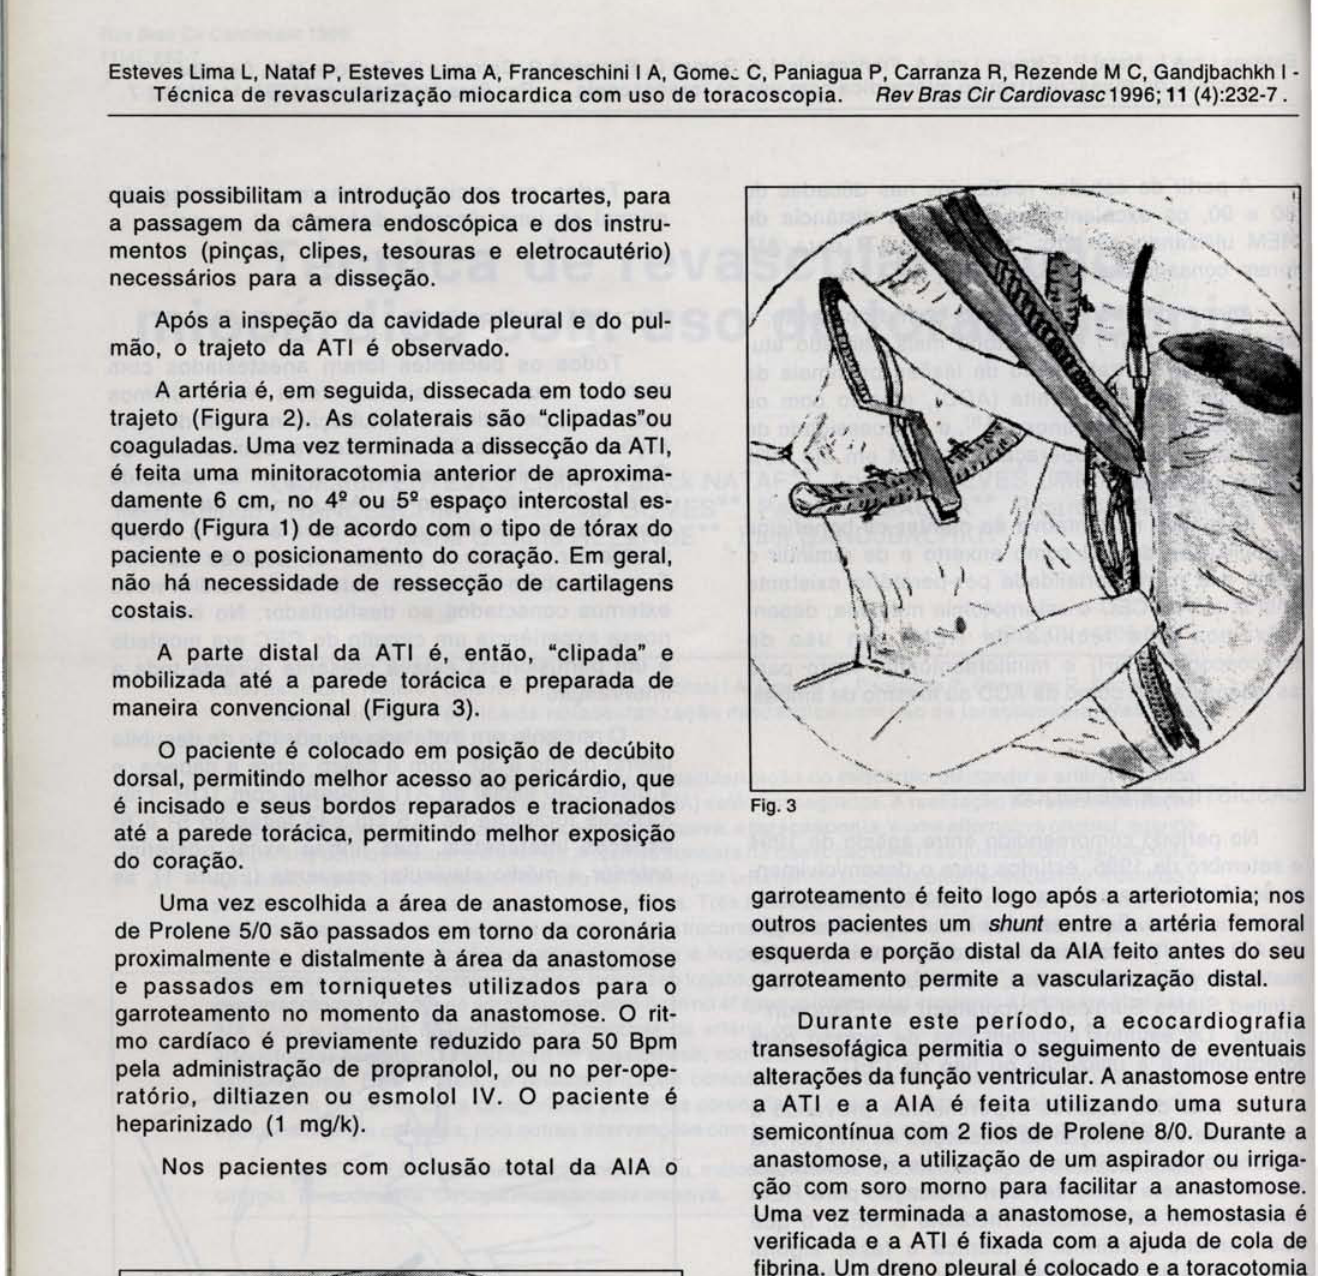
garroteamento é feito logo após a arteriotomia; nos outros pacientes um shunt entre a artéria femoral esquerda e porção distal da AIA feito antes do seu garroteamento permite a vascularização distal. Durante este período, a ecocardiografia transesofágica permitia o seguimento de eventuais alterações da função ventricular. A anastomose entre a ATI e a AIA é feita utilizando uma sutura semicontínua com 2 fios de Prolene 8/0. Durante a anastomose, a utili,zação de um aspirador ou irriga ção com soro morno para facilitar a anastomose. Uma vez terminada a anastomose, a hemostasia é verificada e a ATI é fixada com a ajuda de cola de fibrina. Um dreno pleural é colocado e a toracotomia e os orifícios dos trocartes são fechados de forma